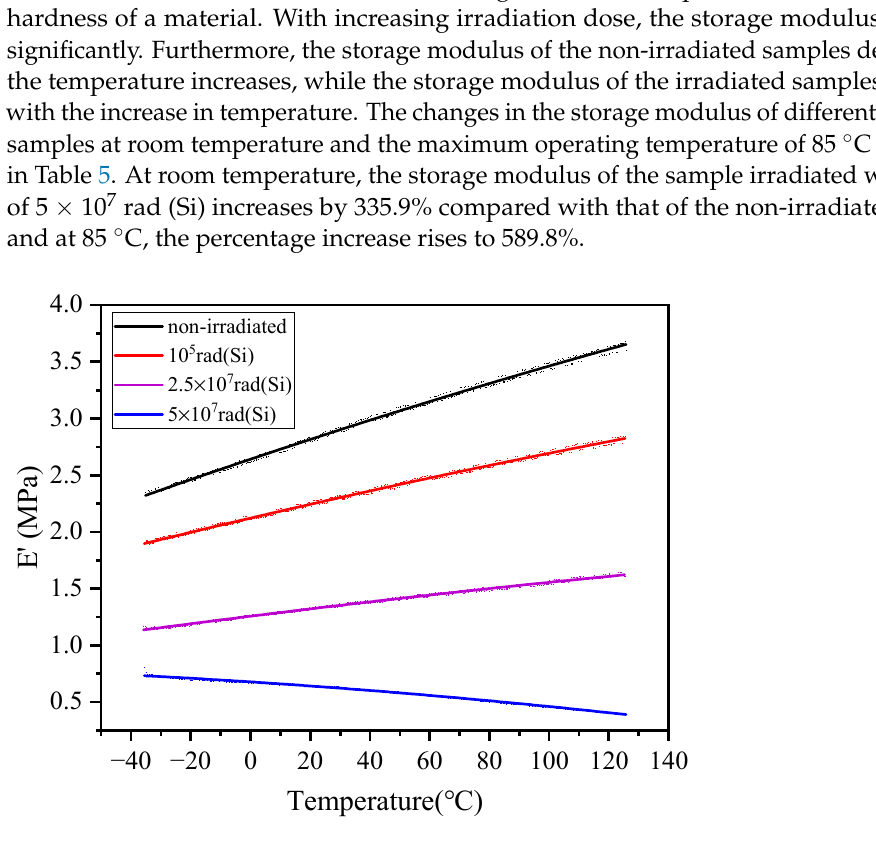
Figure 12. Changes in the storage modulus of Silicone encapsulant under different irradiation doses. Table 5. Storage modulus of encapsulant with different radiation doses at different temperatures. Samples